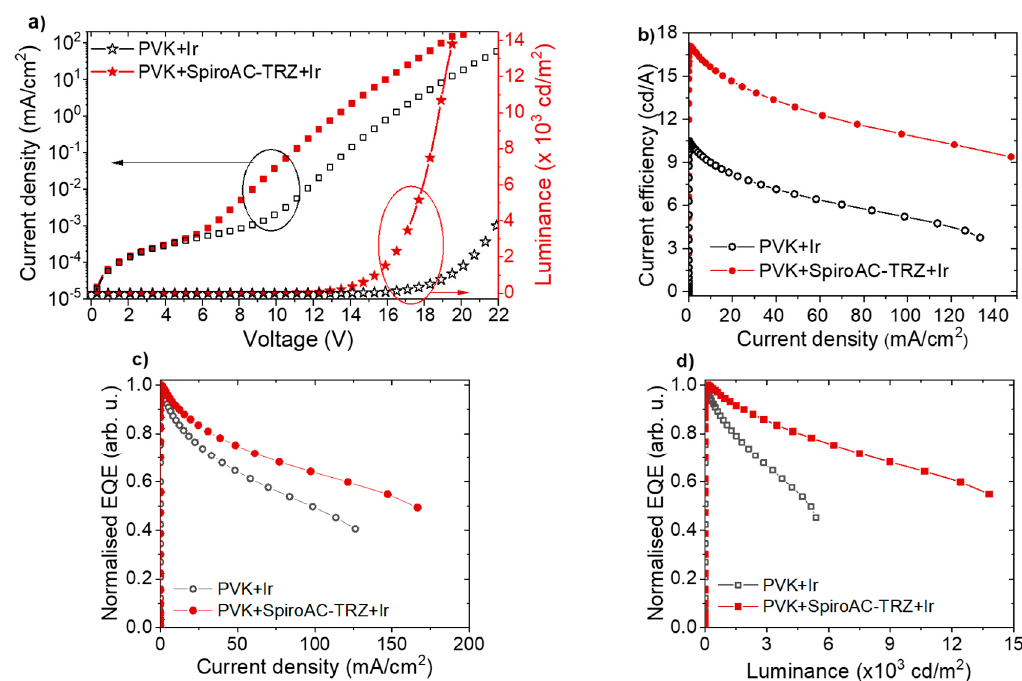
Figure 5. Working parameters of OLEDs with the following structure: ITO/PEDOT:PSS (20 nm)/LEL (70 nm)/TPBi (40 nm)/Liq (2 nm)/Ag (100 nm), where LEL is based on PVK+2wt% Ir (black) or PVK+25 wt% SpiroAC–TRZ+2 wt% Ir (red); ( a ) J – V – L characteristics, ( b ) current efficiency vs current density, ( c ) EQE (external quantum efficiency) vs current density, ( d ) EQE vs luminance.